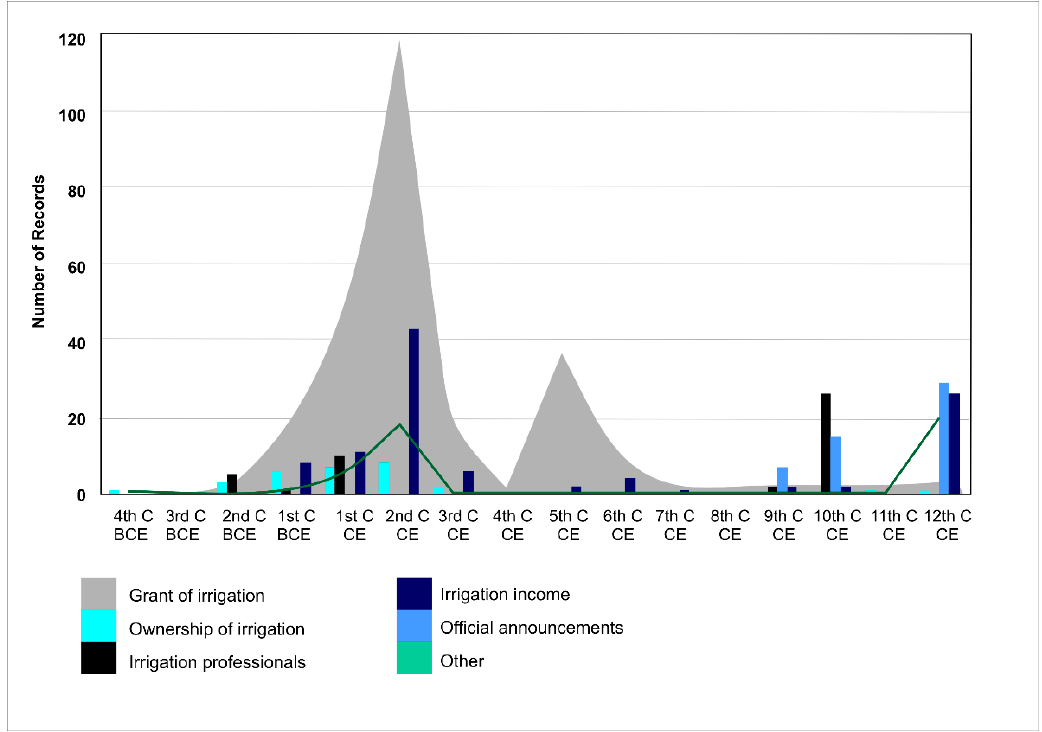
Figure 3. Temporal distribution of analyzed records in different categories of ancient water governance